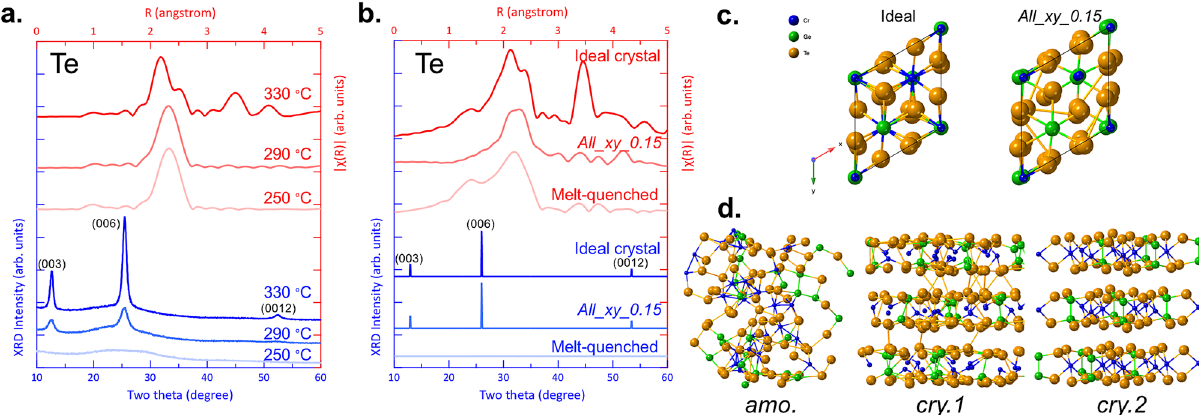
Figure 4. ( a ) Experimental XRD patterns and EXAFS spectra for different annealing temperatures. ( b ) Simulated XRD and EXAFS results for models with different atomic arrangements. ( c ) Top-view for the ideal and All_xy_0.15 models from the z-axis. ( d ) Schematic evolution of crystallization for Cr 2 Ge 2 Te 6 with three representative